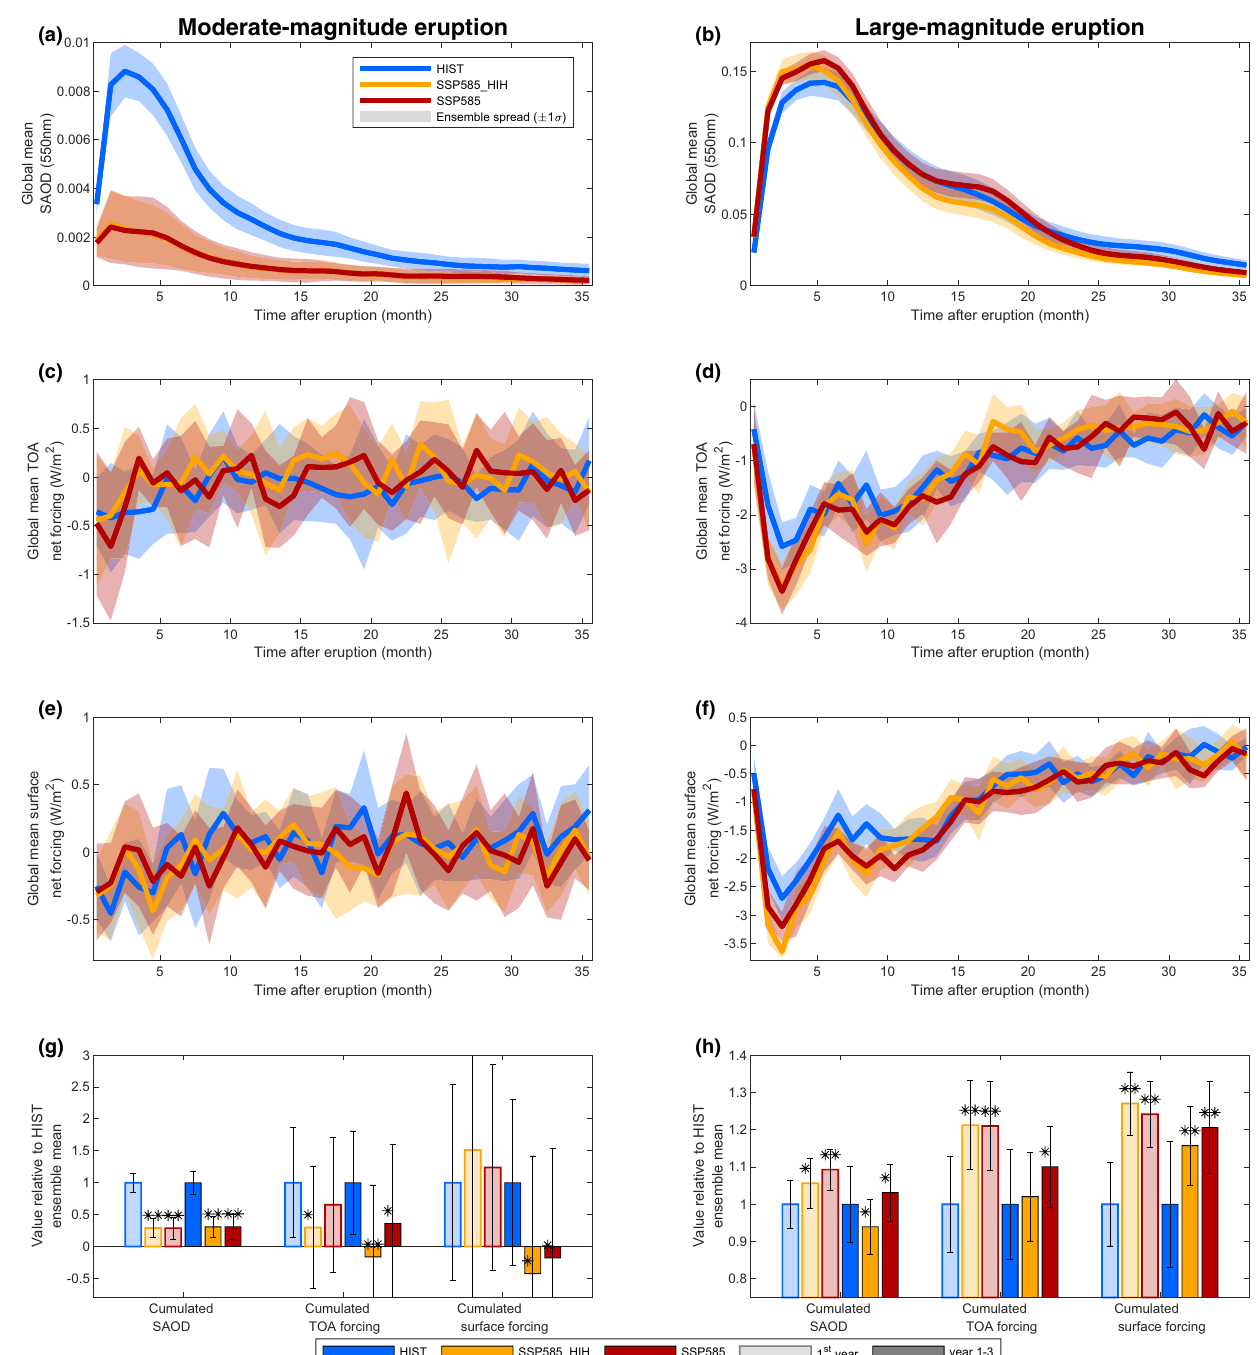
Fig. 3 Stratospheric aerosol optical depth (SAOD) and radiative forcing in our simulations. Time series of global-mean SAOD anomaly at 550nm ( a , b ), global-mean net top-of-the-atmosphere (TOA) radiative fl ux anomaly ( c , d , in W m − 2 ), and global-mean net surface radiative fl ux anomaly ( e , f , in W m − 2 ) for the three scenarios. Thick lines show the ensemble mean and shading shows the spread as one standard deviation across ensemble members. The bottom bar graphs ( g , h ) show time-integrated values of the above time series for the fi rst post-eruption year and the fi rst 3 post-eruption years, normalized by the ensemble mean for the HIST scenario. Error bars for the bottom bar graph show the ensemble spread; a single (double) star indicates that the change relative to the HIST experiment is signi fi cant at the 80% (95%) level. Left plots ( a , c , e , g ) show results for the moderate-magnitude eruption (1Tg), right plots ( b , d , f , h ) show results for the large-magnitude eruption (10Tg). The HIST scenario represents the historical climate and the SSP585 scenario is an upper-end future climate scenario. SSP585_HIH is as SSP585 but uses SO 2 injection heights consistent with the HIST SSP585 scenario and 12.2 months in SSP585_HIH (Fig. 5c, all